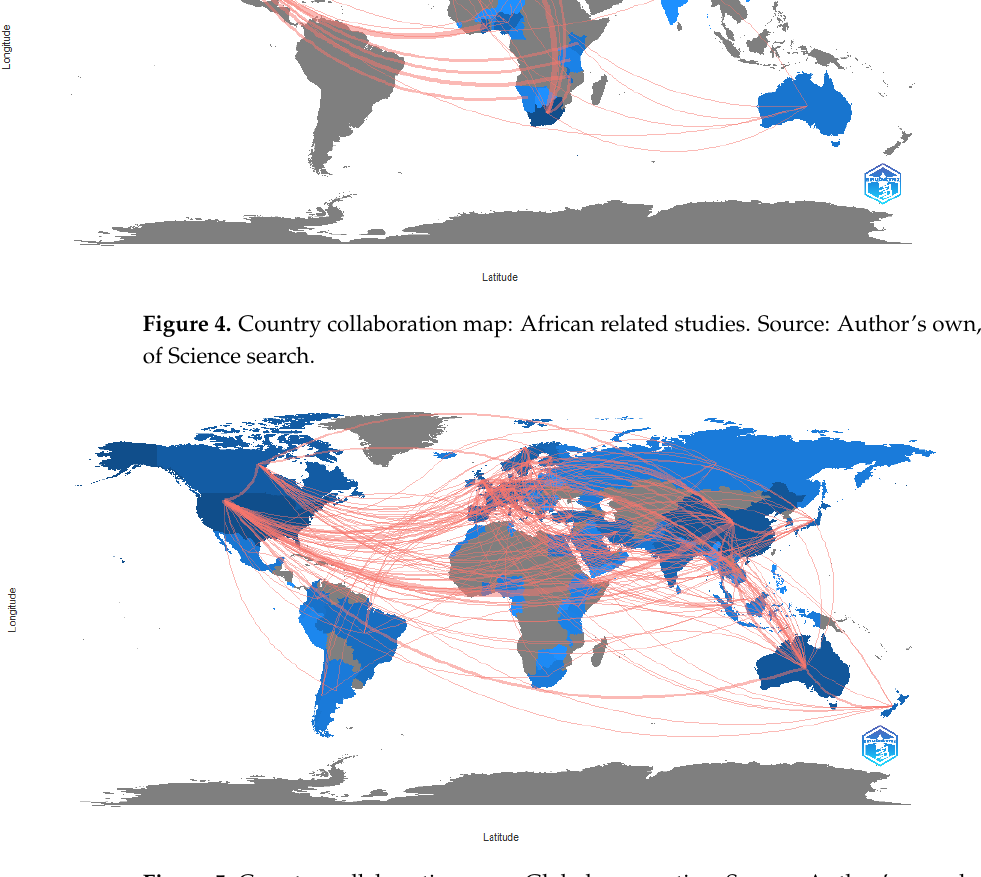
Figure 5. Country collaboration map: Global perspective. Source: Author’s own, based on Web of Science search.